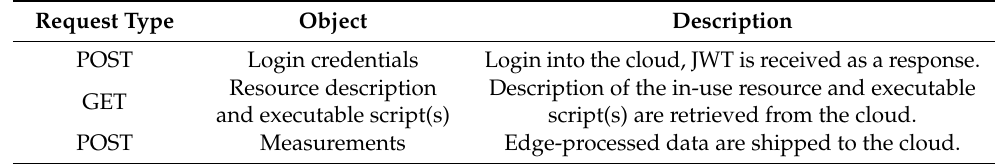
Figure 2. Block diagram of a field device. Table 3. HTTP requests performed by Edgine.